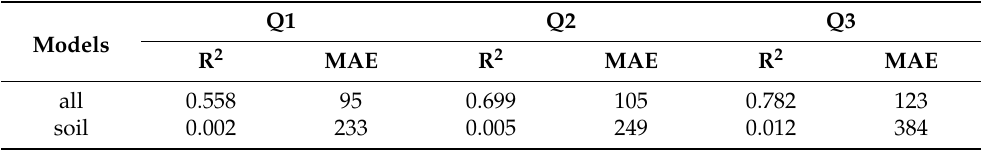
Table 6. Model performances of random forest regressions (RFR) based on 10-fold cross-validation and three repetitions (Q1–Q3); (all: possible variables; soil: only soil properties according to Table 1). Q1 Q2 Q3 Models R 2 MAE R 2 MAE R 2 MAE all 0.558 95 0.699 105 0.782 123 soil 0.002 233 0.005 249 0.012